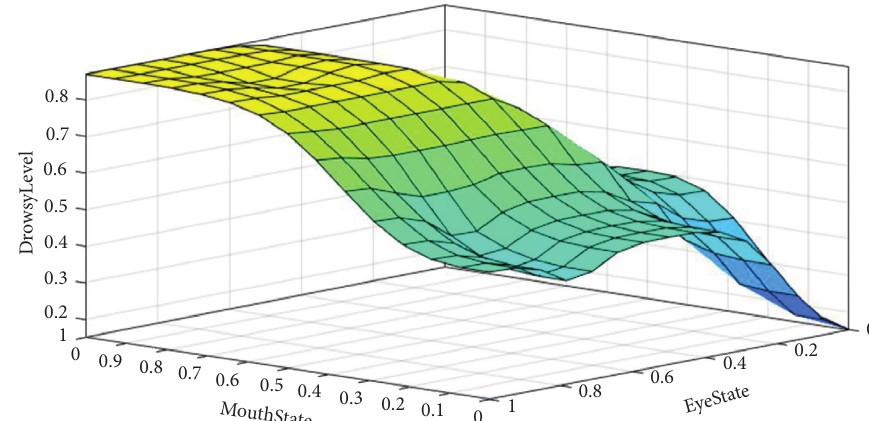
Figure 12: Surface viewer of fuzzy inference system.